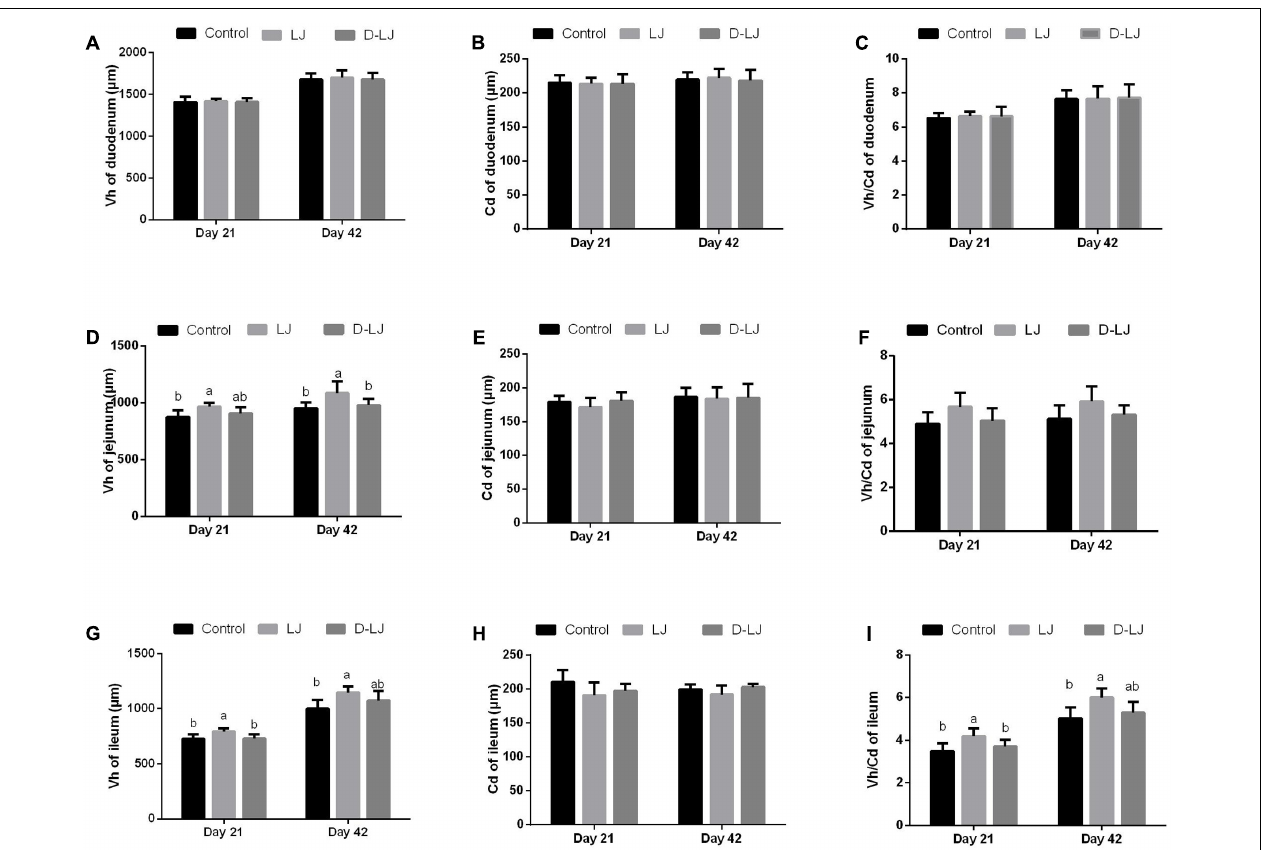
FIGURE 4 | Villus morphology of the small intestine. Bars with different letters are significantly different on the basis of Duncan’s multiple range tests ( P < 0.05). Data are presented as mean ± standard deviation (six replicates of one chick per cage). (A–C) Villus height, crypt depth, and villus height/crypt depth ratio of duodenum;